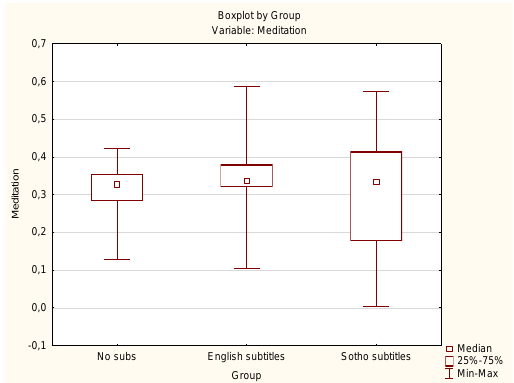
Figure 9. Boxplots representing the data from the EEG channels